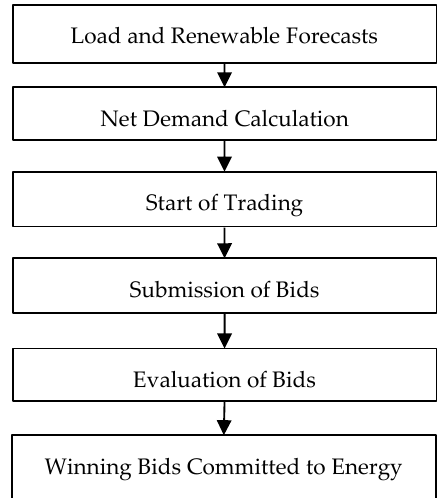
Figure 1. Flowchart of the electricity market clearing process.